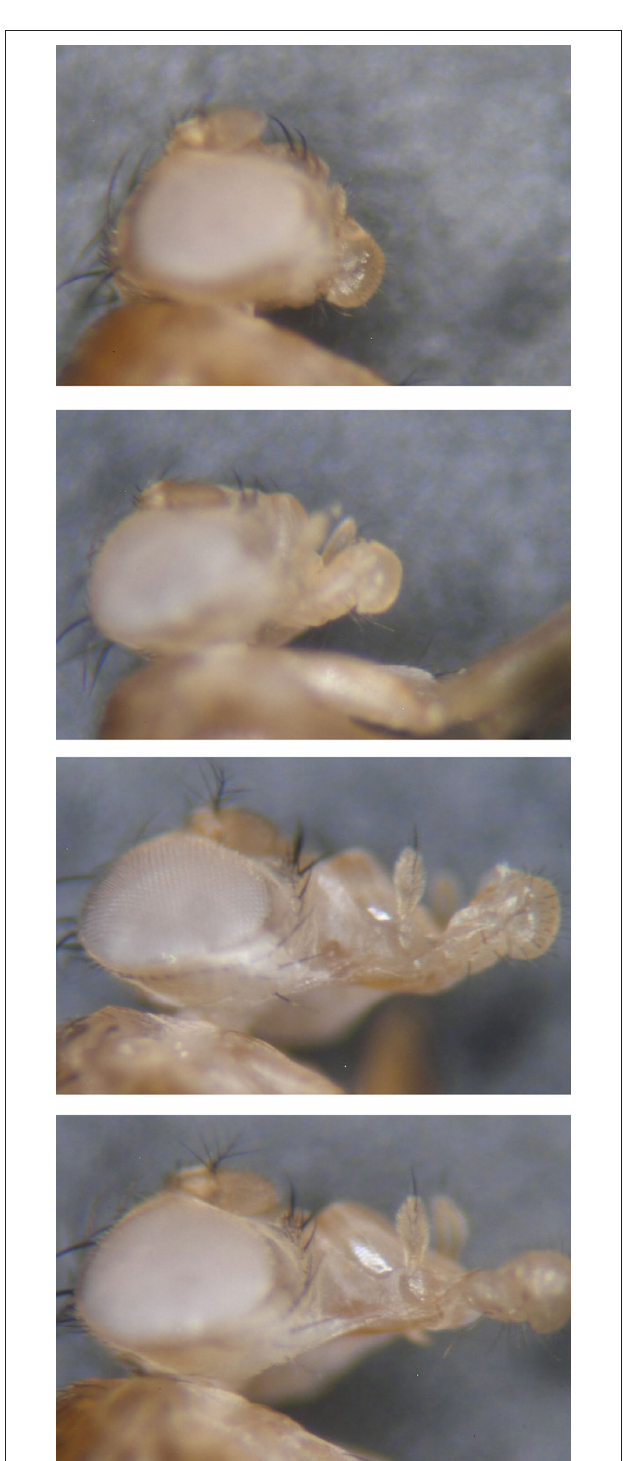
FiGuRe 2 | increasing magnitude of proboscis extension response (from up to down) in